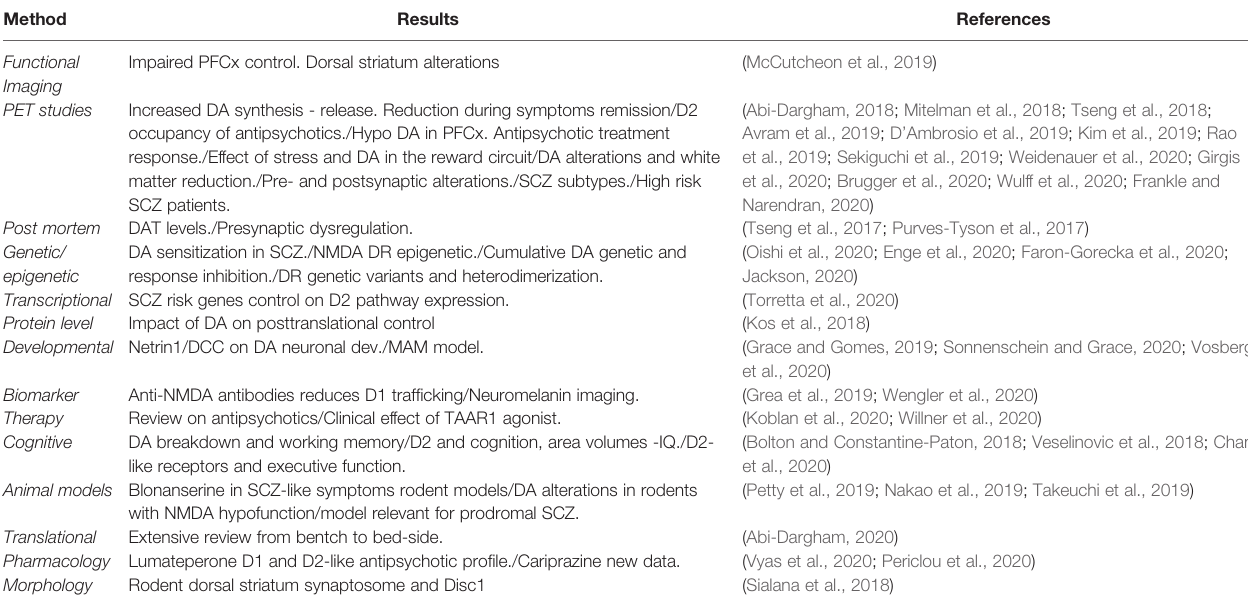
TABLE 1 | Summary of most recent evidence of dopaminergic alterations in